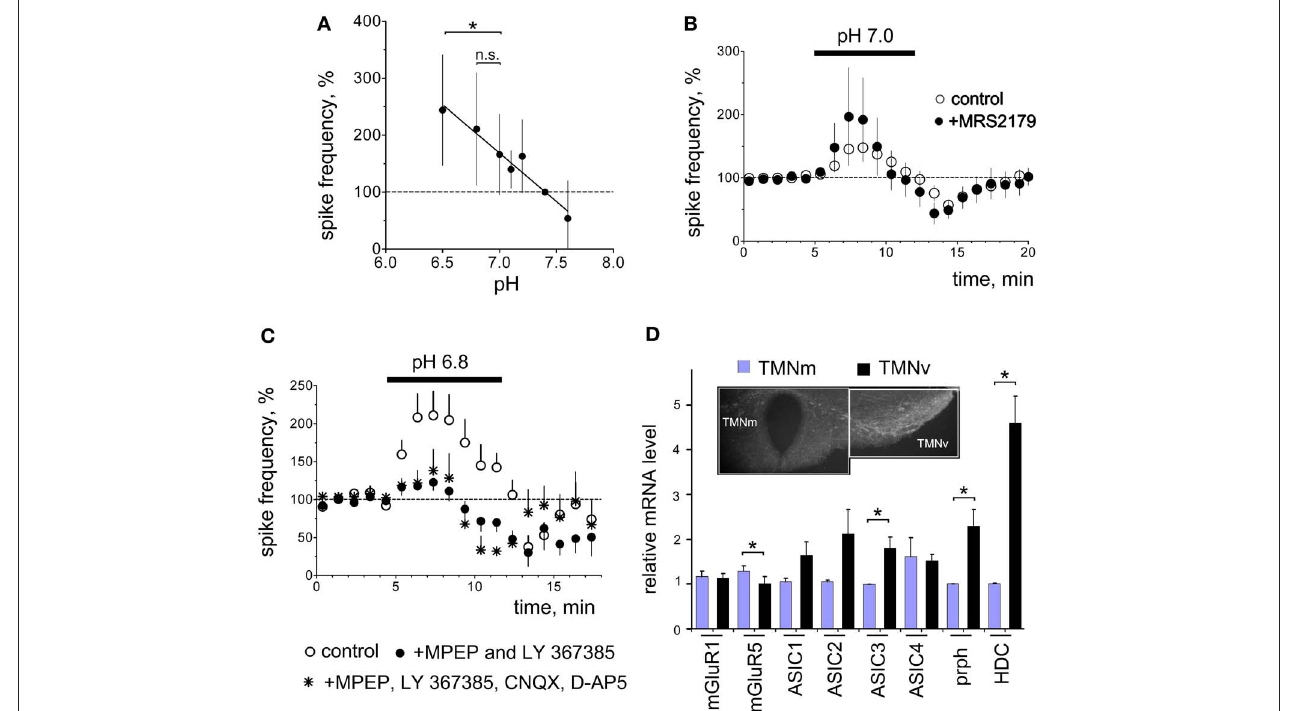
FIGURE 2 | Functional identification and expression analysis of acid-sensors in TMN. (A) Acid-induced excitation depends on the degree of acidification. Each data point is an average of 4–23 neurons. The difference in excitation between pH 6.5 and 7.0 but not between pH 6.8 and 7.0 is significant ( ∗ p < 0 . 05). (B) The P2Y1 receptor antagonist MRS2179 ( n = 5) does not prevent pH 7.0-excitation. Control diagram represents the average of 23 neurons. (C) Facilitation of firing in control and in the presence of the metabotropic GluR (mGluR) antagonists MPEP (mGluR5, 10 μ M) and LY367385 (mGluR1, 20 μ M) or mGluR antagonists combined with inotropic